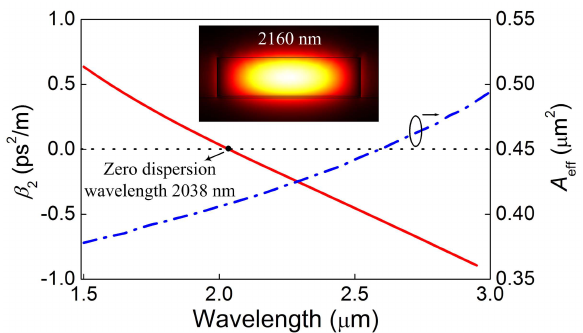
Figure 13: Second-order dispersion and effective mode area as a function of the wavelength. Inset: the cross-section of the SOI waveguide and the transverse profiles of the electric field for quasi- TE polarization calculated at 2160 nm.